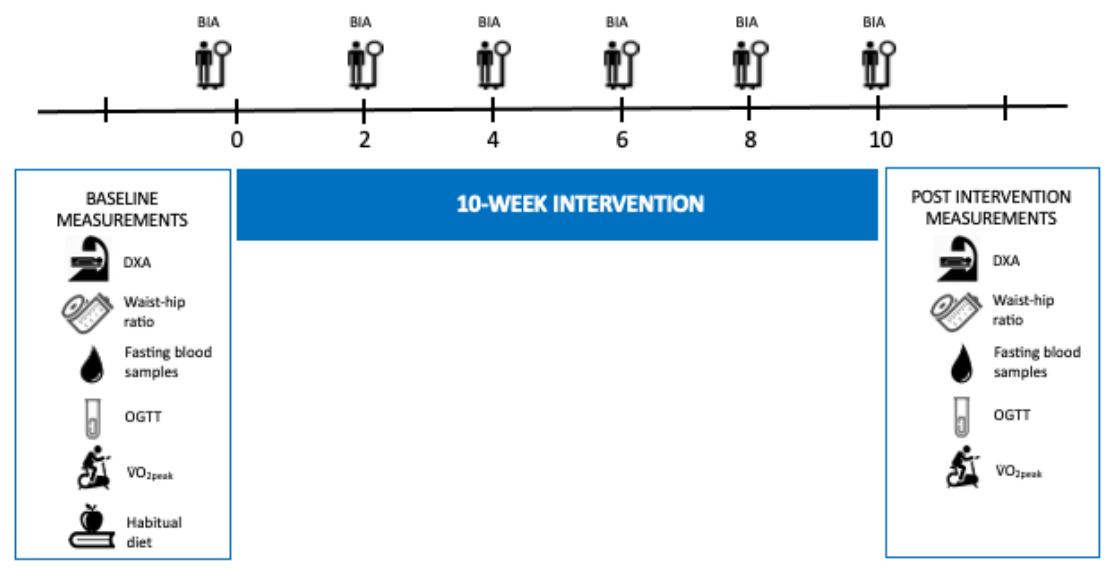
Figure 4. The figure shows measurements during baseline, intervention and post-intervention. During the baseline period, all participants registered their habitual diet for 4 days, and all groups kept dietary records throughout the intervention (not shown in the figure). A 2-week period has been highlighted to show exercise sessions for the exercise groups (NORM-EX and LCHF-EX) where the diet only groups (NORM and LCHF) continued their sedentary lifestyle. This procedure was performed throughout the intervention. All groups were weighed every second week using a BIA device. DXA: Dual-energy X-ray absorptiometry, OGTT: Oral Glucose Tolerance Test, VO 2peak : Peak Oxygen Uptake, BIA: Bioelectrical Impedance